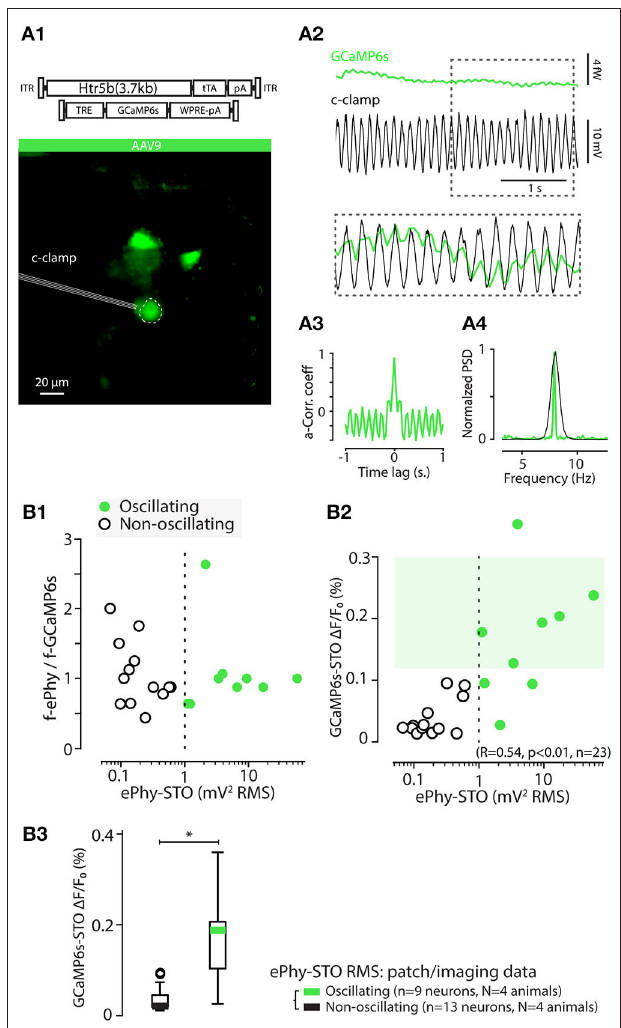
FIGURE 10 | GCaMP6s-STOs are reporting electrophysiological STOs in vitro . (A) Example of a simultaneous patch clamp and calcium imaging recording of an IO cell in-vitro . (A1) shows the standard deviation projection image of the recorded time series, with the patched cell indicated with a dashed line. Note that the image brightness is adjusted for viewing and should not be considered as representative of the dynamic range during live imaging. (A2) time-aligned GCaMP6s trace (top) and (V m ) trace (middle). The section of traces indicated by dotted rectangle is shown overlaid in bottom. The autocorrelation of the calcium trace (A3) as well as comparison of its Welch spectrum with that of the electrophysiological recording (A4) show stable oscillatory behavior in this cell. (B) The frequency of GCaMP6s STOs closely matches that of electrophysiological recordings. (B1) Frequency ratios of voltage ( y -axis) and fluorescence ( x -axis) signals is flat over large range of oscillation power. Dotted line indicates a threshold of 1 mV 2 RMS used to classify cells as “oscillating” or “non-oscillating.” (B2) Relation between electrophysiological STO power and GCaMP6s STO amplitude. Dotted line indicates the 1 mV 2 RMS threshold value as in (B1) . (B3) Comparison of STO power of the GCaMP6s signal obtained from cells classified as oscillating (green) or non-oscillating (black) based on the 1 mV 2 RMS threshold (Welch t-test, t = -4.99, p <0.05).